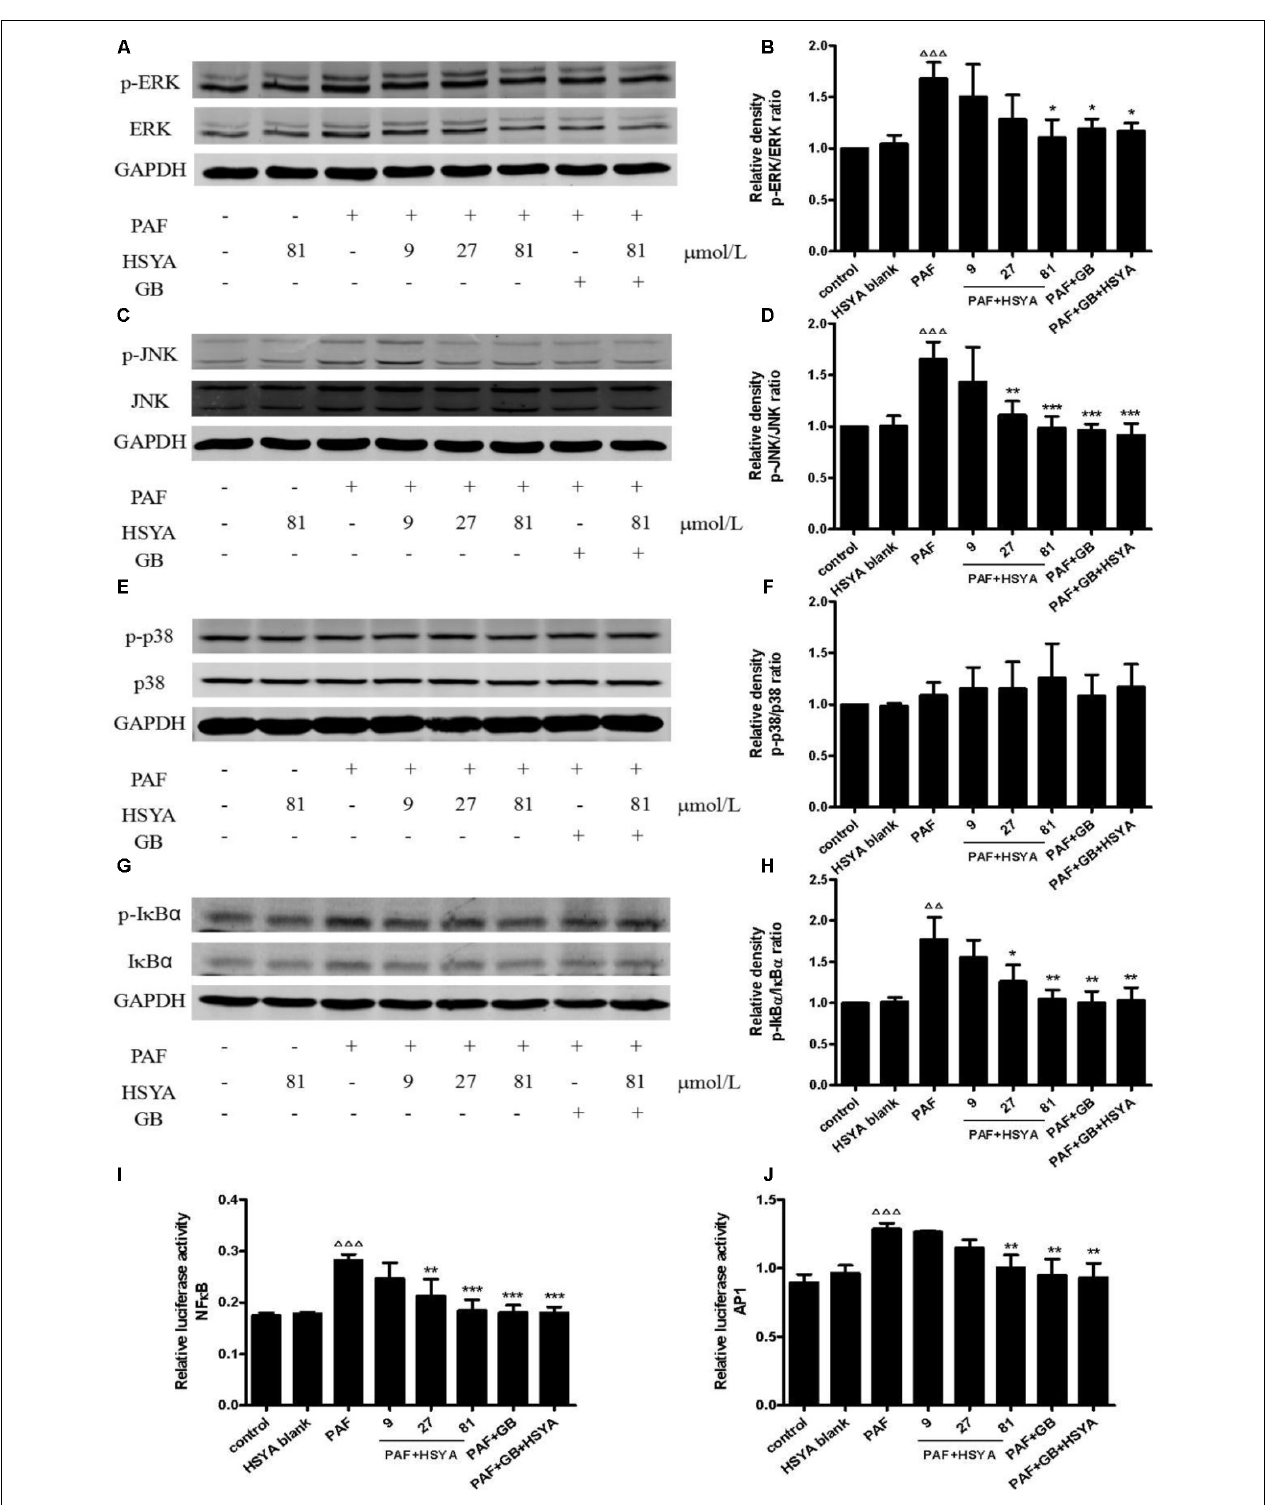
FIGURE 8 | Effects of HSYA on MAPK (ERK, JNK, p38) pathway and transcriptional activities of NF κ B and AP1 in PAF-stimulated HSAECs. Phosphorylation levels of ERK (A) , JNK (C) , p38 (E) , and I κ B (G) were determined by western blot and quantified by densitometric analysis (B, D, F, H) . Binding activities of NF κ B (I) and AP1 (J) were determined by dual-luciferase assay. Data presented as mean ± SD, n = 3 per group. ANOVA, p < 0.001 (B) , p < 0.001 (D) , p > 0.05 (F) , p < 0.01 (H) , p < 0.001 (I) , p < 0.001 (J) . post hoc (cid:49)(cid:49) p < 0.01, (cid:49)(cid:49)(cid:49) p < 0.001 versus control group, ∗ p < 0.05, ∗∗ p < 0.01, ∗∗∗ p < 0.001 versus PAF group. GAPDH was used as an internal